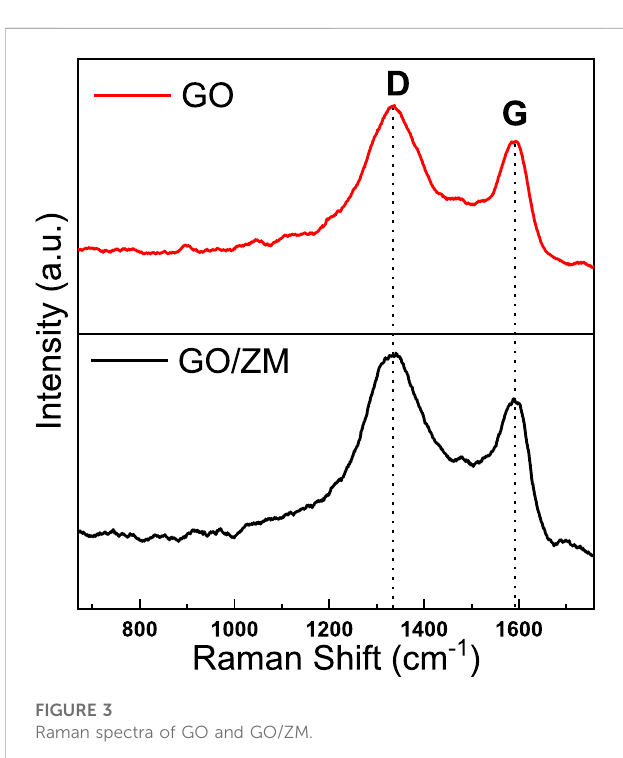
FIGURE 3 Raman spectra of GO and GO/ZM.